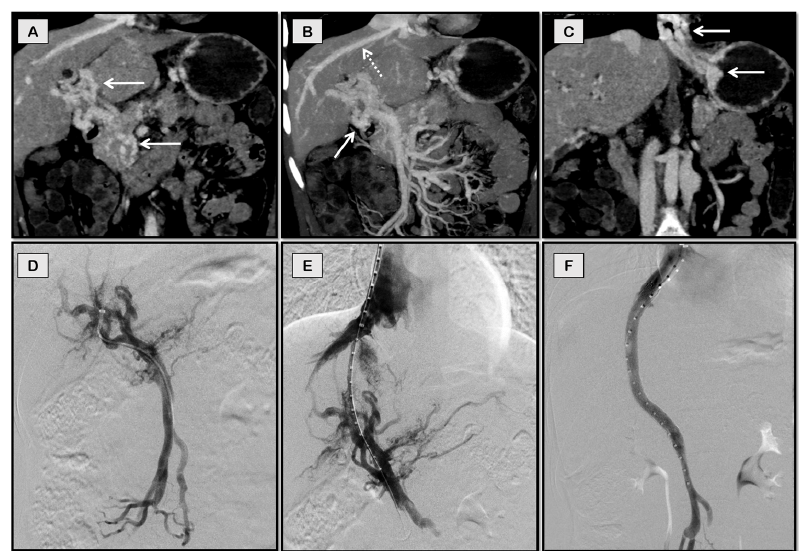
Figure 7. TIPS through a collateral vein for recurrent variceal bleeding in a 17-year-old girl with chronic non-cirrhotic portal vein thrombosis. She had undergone a splenectomy at the age of 6 years and was not a candidate for Rex shunt. Coronal-oblique CT images ( A – C ) showing portal cavernoma (arrows in A ), dominant collateral vein (dashed arrow in B ) in the same plane as middle hepatic vein (solid arrow in B ), and esophageal and gastric varices (arrows in C ). The collateral vein was accessed through a jugular route ( D ) and stented ( E ) with flow restoration and disappearance of collaterals ( F ).